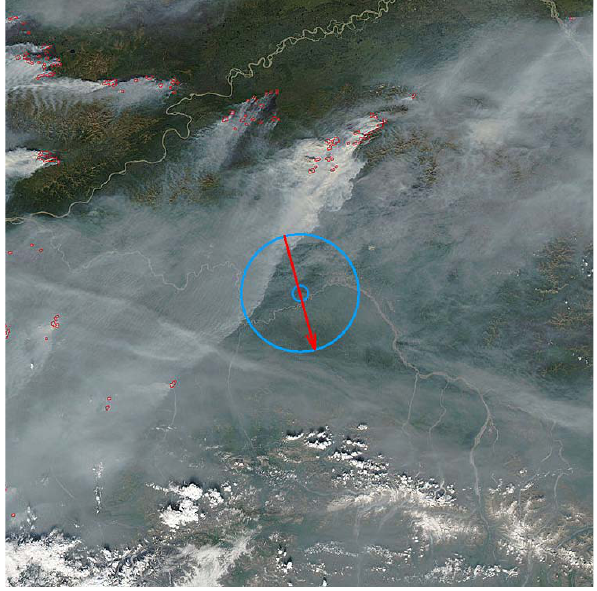
Fig. 4. True-color picture of Alaska forest fires acquired by the Aqua MODIS sensor on 15 August 2005 at 22:30UTC over Bo- nanza Creek AERONET station. The smaller circle in the center of the picture shows the location of the station, while the larger circle highlights the MAPSS sampling area over this station. The red arrow represents the azimuth of the slope of the fitted plane ( slaz =164.83). In this case, the arrow points from the pixels in the sample with the highest AOD (thick smoke plume) to the pix- els with the lowest AOD (thin smoke plume), as indicated by the steeper slope of the fitted plane ( slop =48.53). Please note that in this case MODIS was able to successfully retrieve AOD in the thick smoke plume in the left part of the sampling area. MAPSS param- eters for this case: slaz : 164.83, slop : 48.53, mcoc : 0.52, mean : 0.9, cval : 0.81, sdev : 0.3, ndat : 21, nval :